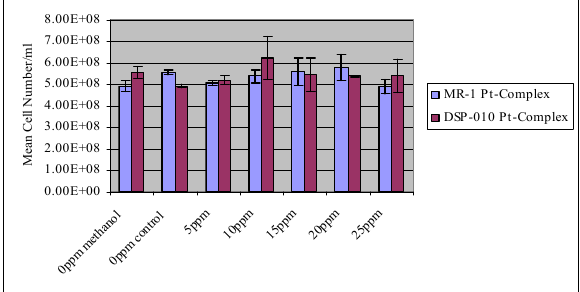
Figure 4: Effects of various concentrations of diphenyl Pt- thiosemicarbazone metal complex on Shewanella oneidensis MR-1 and DSP-010 grown aerobically in LB broth. Mean cell/ml was determined at 37 ˚ C after a 48 hour time period for three independent experiments.